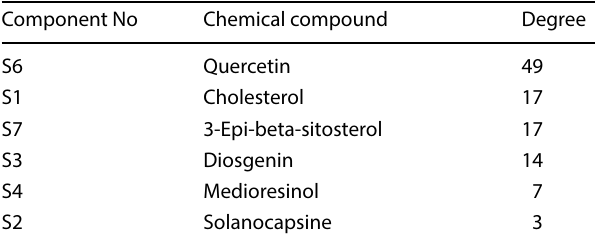
Table 2 Network degree values of the 6 active ingredients of S. nigrum Component No